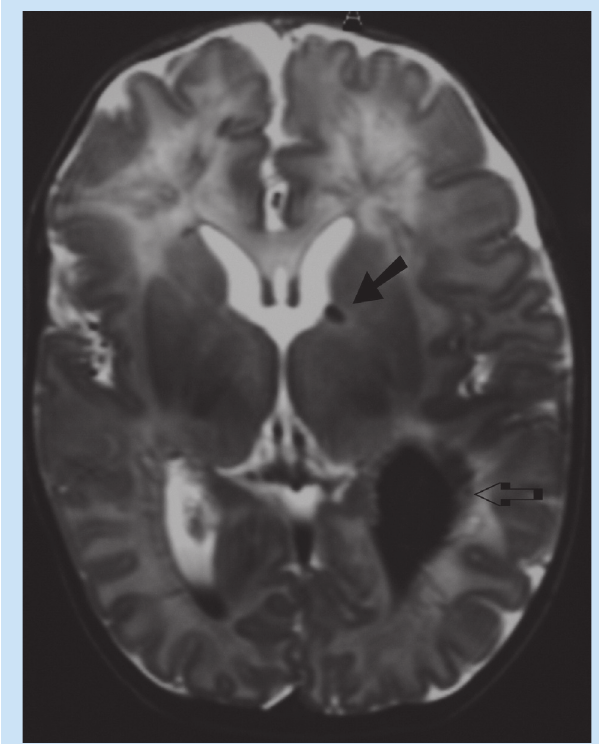
Fig. 2.1a. MRI changes in a preterm neonate: T2 periventricular white matter high signal, subependymal haemorrhage (arrow), left parenchymal haemor- rhage and intraventricular haemorrhage (open arrow) in posterior horns of lateral ventricles.